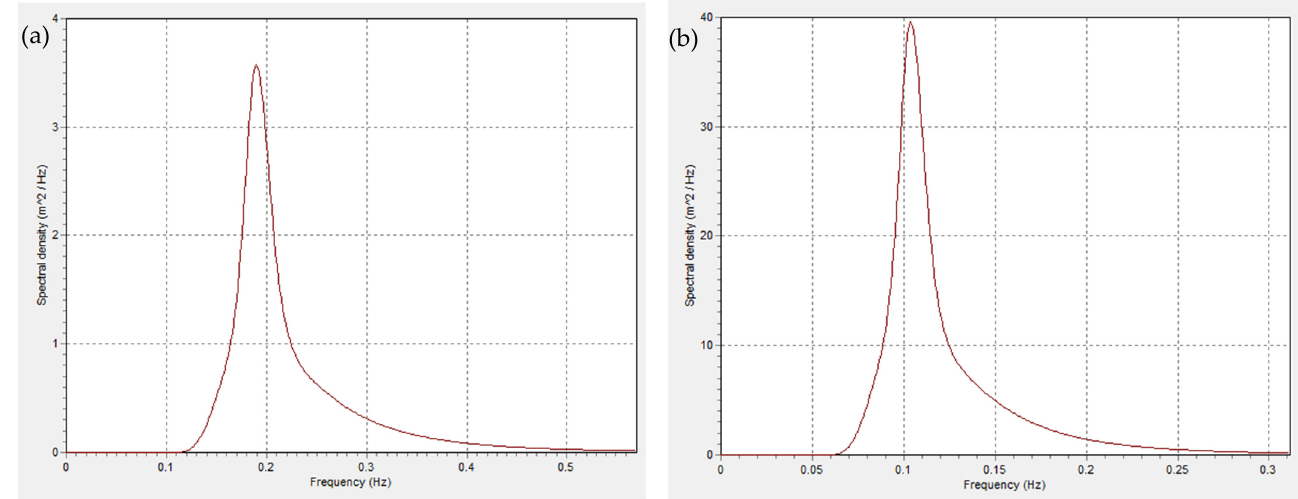
Figure 13. The JONSWAP wave spectrum for the ( a ) first sea state and ( b ) third sea state.